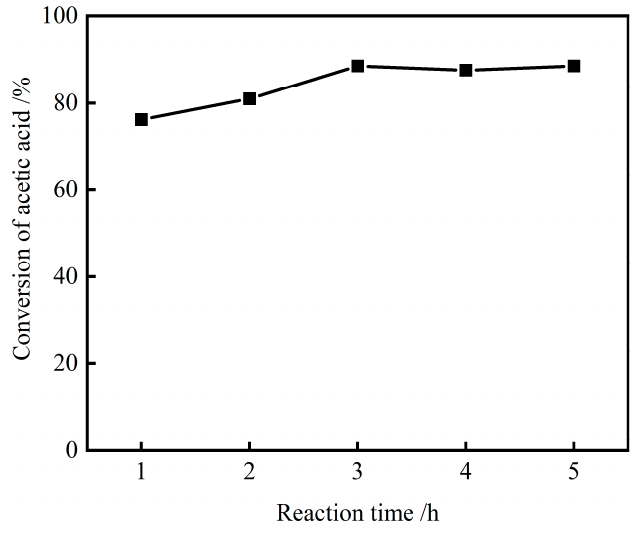
Figure 10. The influence of reaction time on the conversion rate of HOAc (reaction conditions: n E- tOH :n HOAc = 6:1, 1 wt% catalyst loading, 80 °C, 640